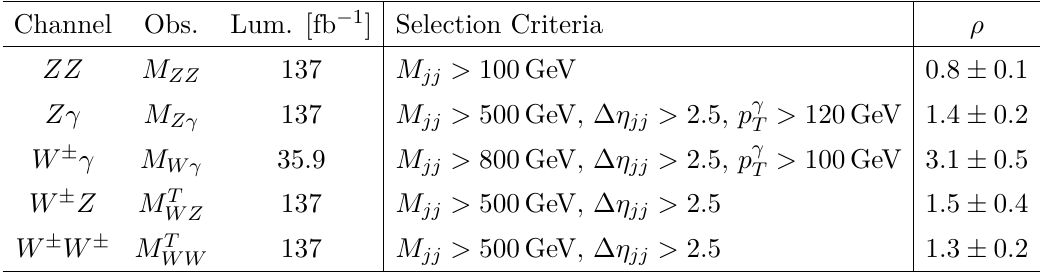
table 3: the diboson mass observable, the integrated luminosity, the selection criteria and the normalization scale factor ρ